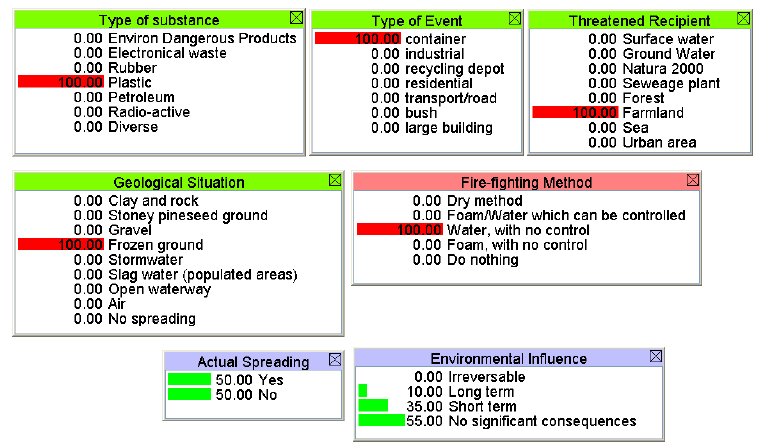
Figure 10: Example of Predictive mode. What if we use ‘Water with no control’ on a particular